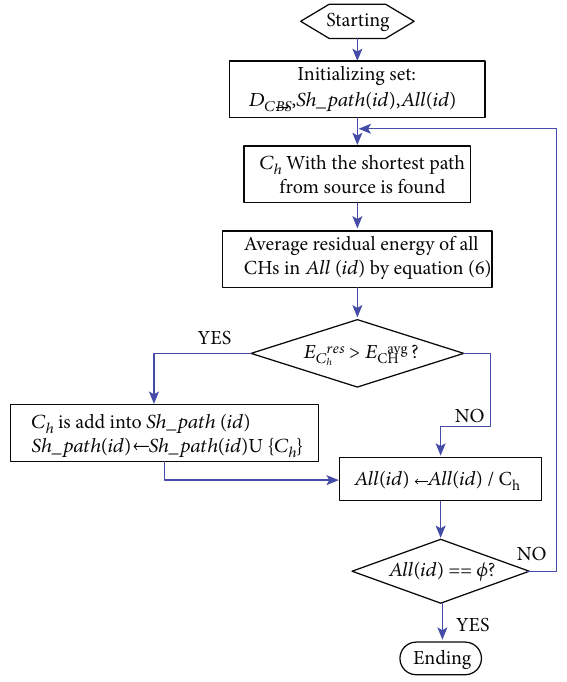
Figure 7: Flowchart of constructing the shortest path.